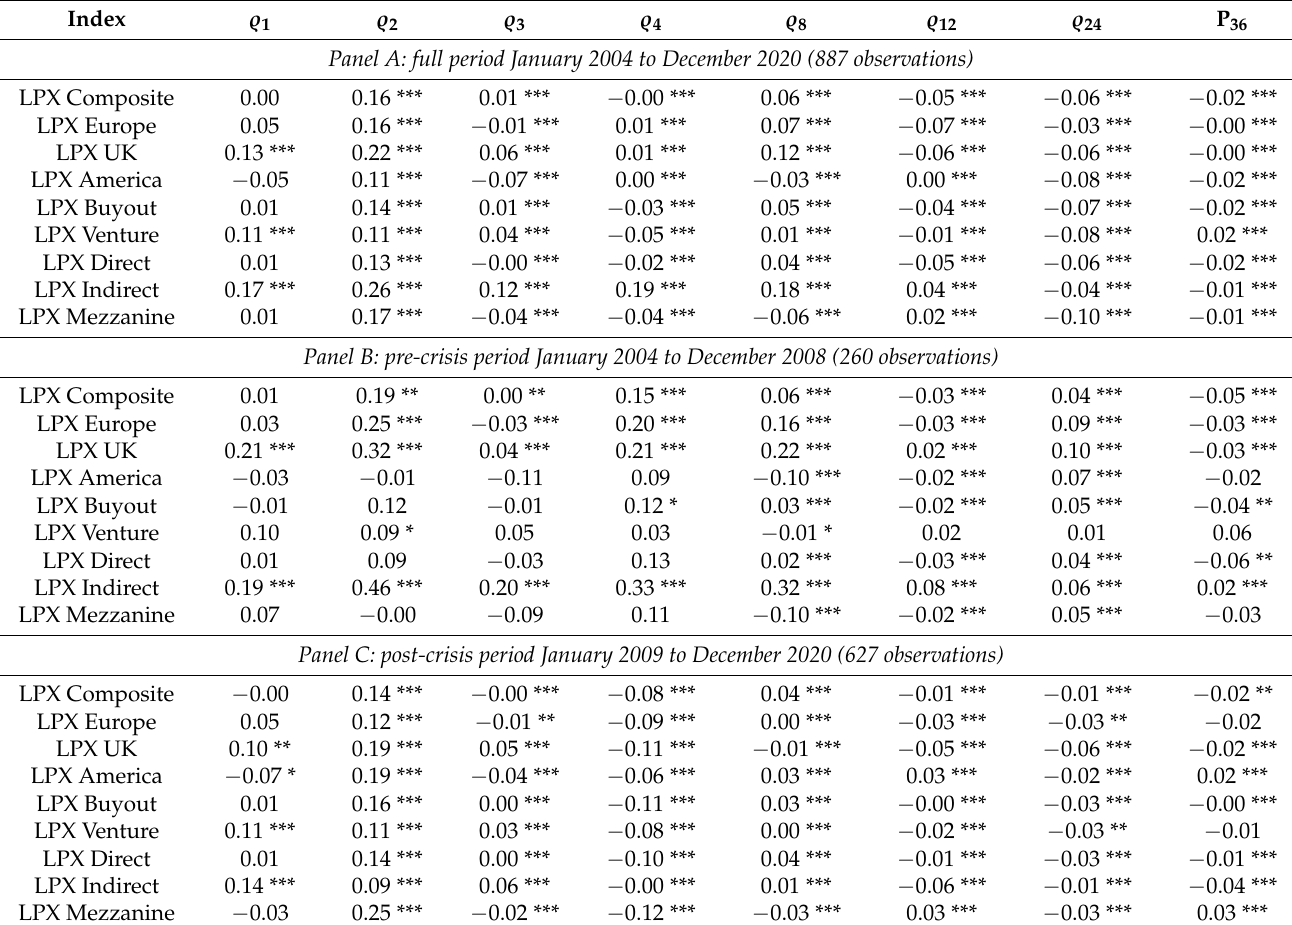
Table 3. Autocorrelations of weekly listed private equity index